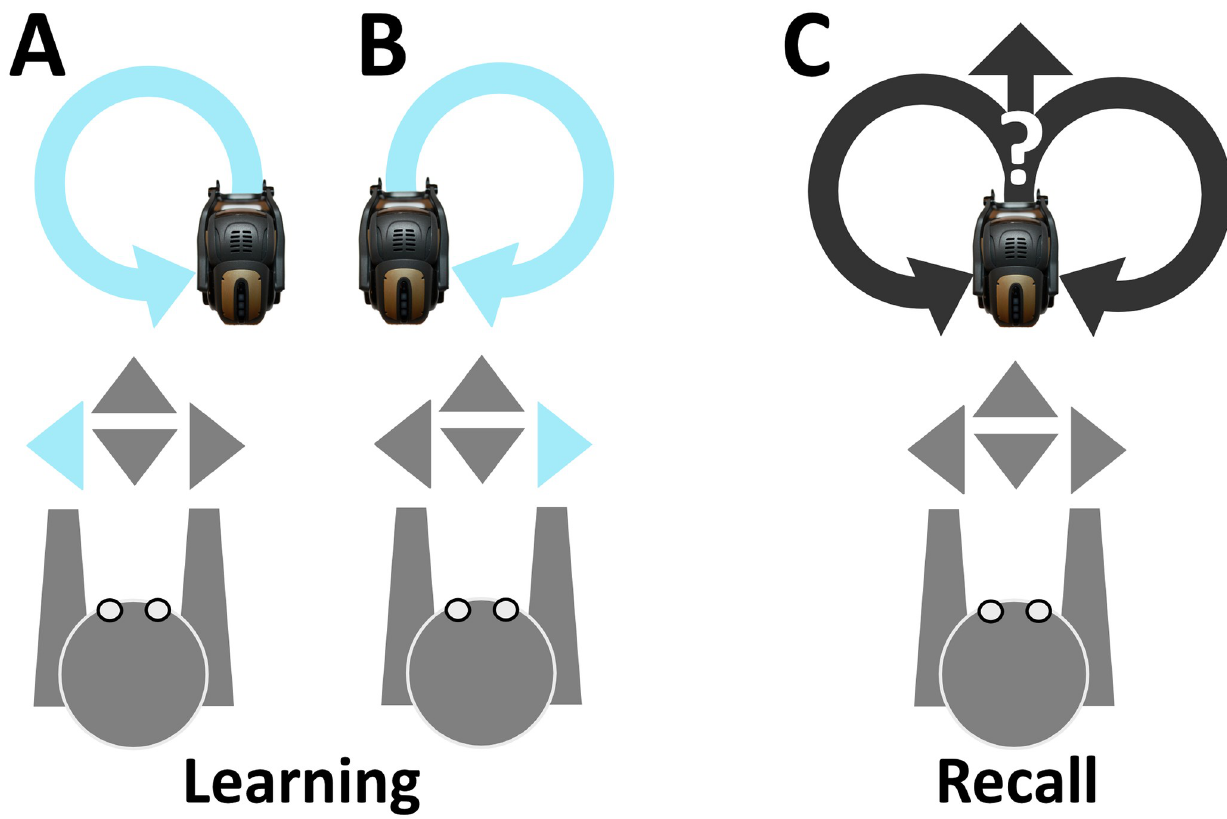
Fig 3. Keyboard listening setup. (A) The < Left > keypress recruits input configuration shown in Fig 2A, marking the onset of input-dependent counter- clockwise motor executions. (B) Same as in (A), but instead the < Right > key is pressed, recruiting input configuration shown in Fig 2B, marking the onset of input-dependent clockwise motor trajectories. (C) The < Enter > key is pressed (not shown), recruiting the homogeneous input configuration shown in Fig 2C, marking the onset of input-disengaged